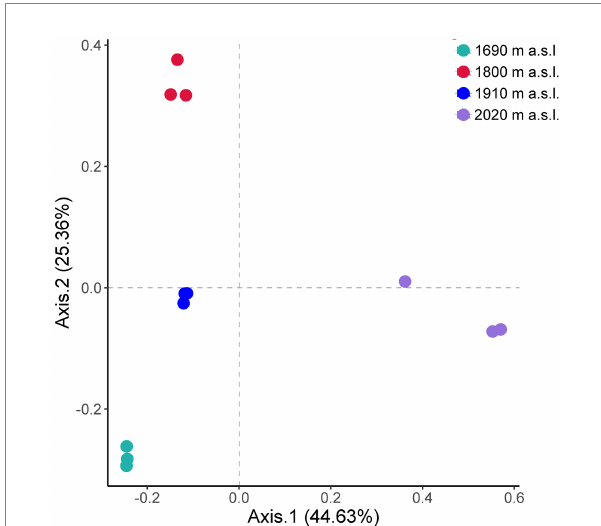
FIGURE 2 Principal coordinate analysis (PCoA) of fungal communities along an elevational gradient on Changbai Mountain, northeastern China. The dominant plant species at the sites were D. angustifolia. Beta- Diversity index was calculated at the OTU level